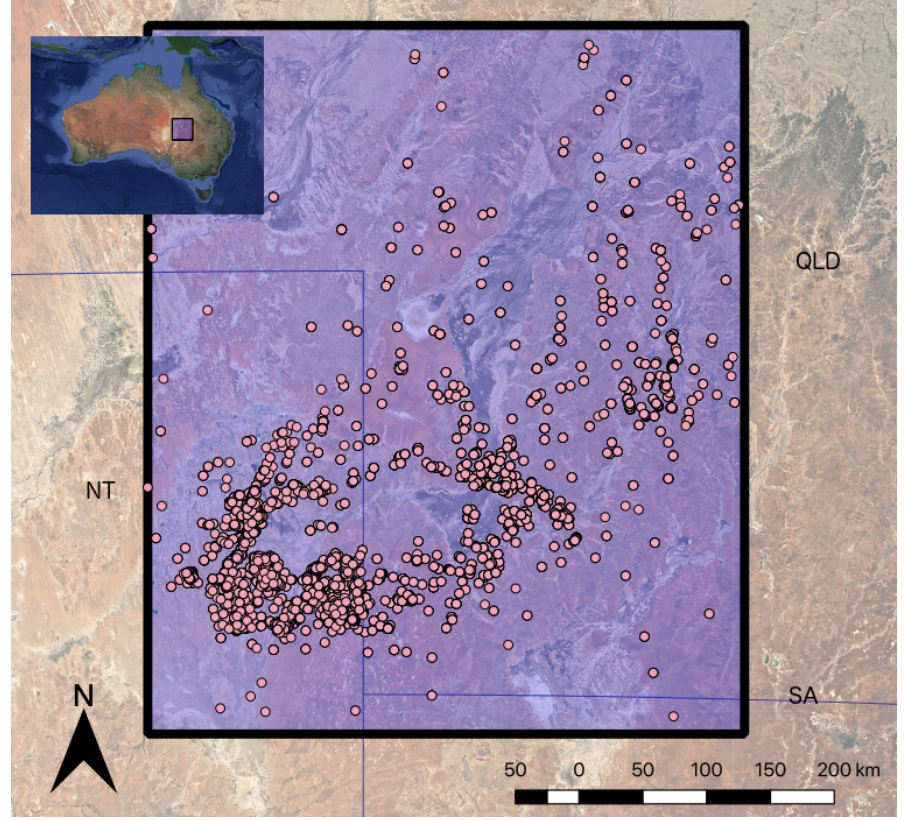
Figure 7. Cooper Basin temperature well locations, with the horizontal extent of the thermal model shaded